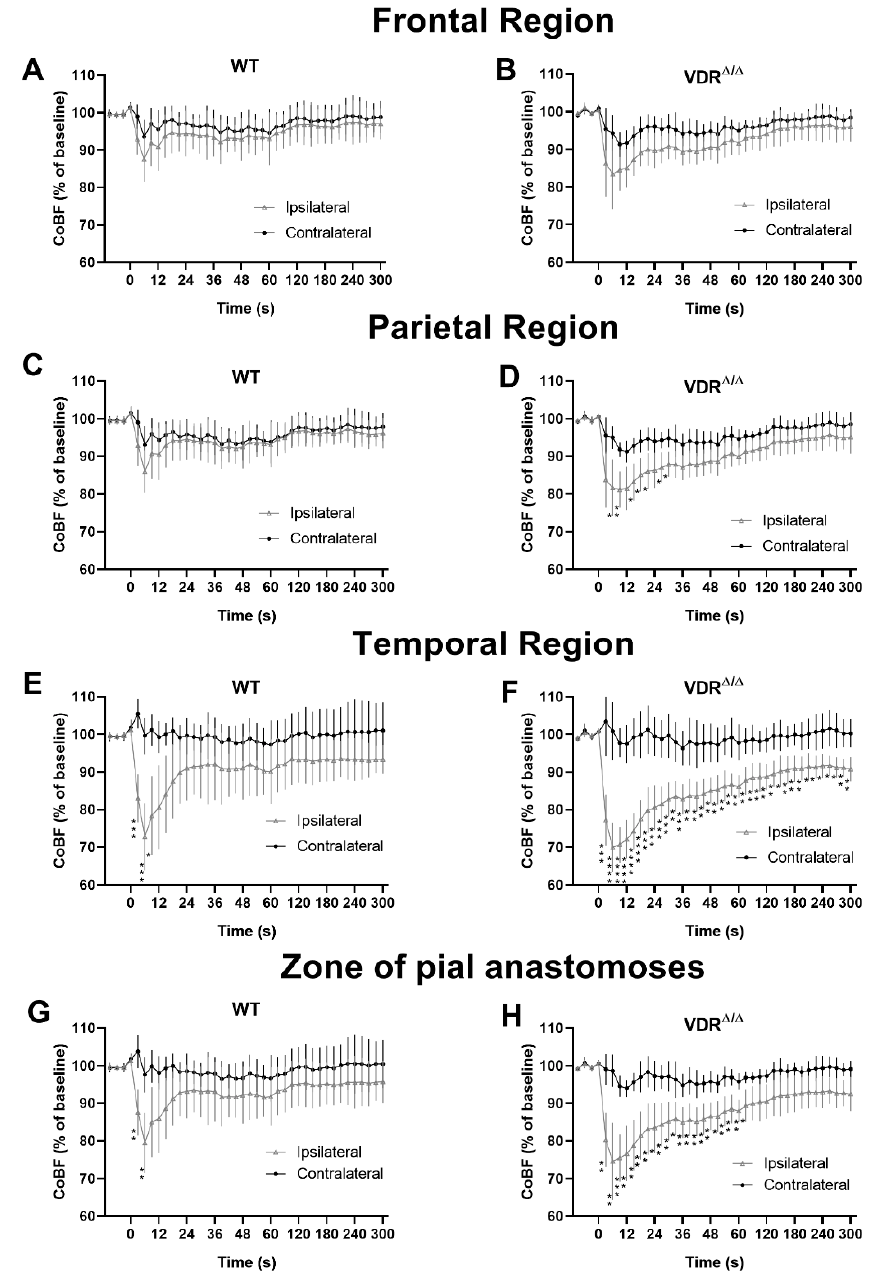
Figure 2. Regional cerebrocortical blood flow (CoBF) changes in WT ( A , C , E , G ) and VDR ∆ / ∆ ( B , D , F , H ) mice following carotid artery occlusion (CAO). Zero time indicates the moment of the left carotid artery occlusion. Black circles and gray triangles represent the CoBF in the contralateral and ipsilateral hemispheres, respectively. CAO did not cause any changes in the CoBF of the ipsilateral frontal cortex as compared to the contralateral one ( A ) in WT or ( B ) VDR ∆ / ∆ mice. ( C ) CAO did not induce any changes in the CoBF of the ipsilateral parietal cortex as compared to the contralateral one in WT mice, whereas ( D ) it resulted in a significant CoBF reduction in the acute phase in VDR Δ / Δ mice. ( E, G ) The CoBF of the temporal cortex and the zone of pial anastomoses ipsilateral to CAO were reduced significantly only in the first few seconds after CAO in WT animals, whereas ( F, H ) a more prolonged CoBF reduction of both zones was determined in VDR Δ / Δ mice. (* p < 0.05, ** p < 0.01, *** p < 0.001, **** p < 0.0001, n = 8 in both groups, two-way repeated measures ANOVA followed by Bonferroni post hoc test). Data are presented as mean ± SD.